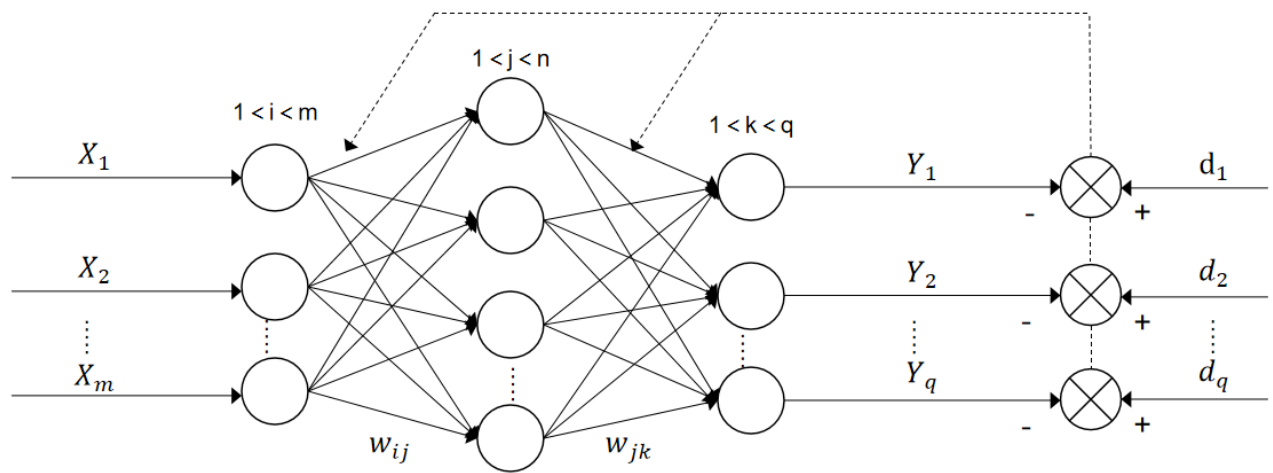
Figure 10. The BP neural network.